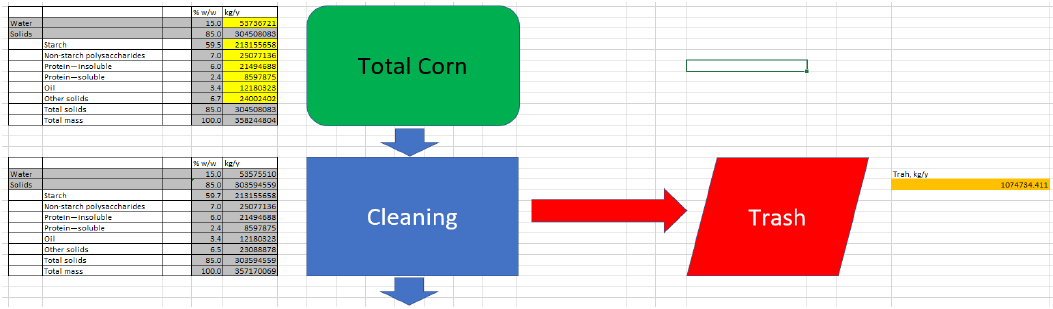
Figure 1. The cleaning process from the ‘Flowchart’ page in the Supplementary Materials (Excel spreadsheet, Technoeconomic